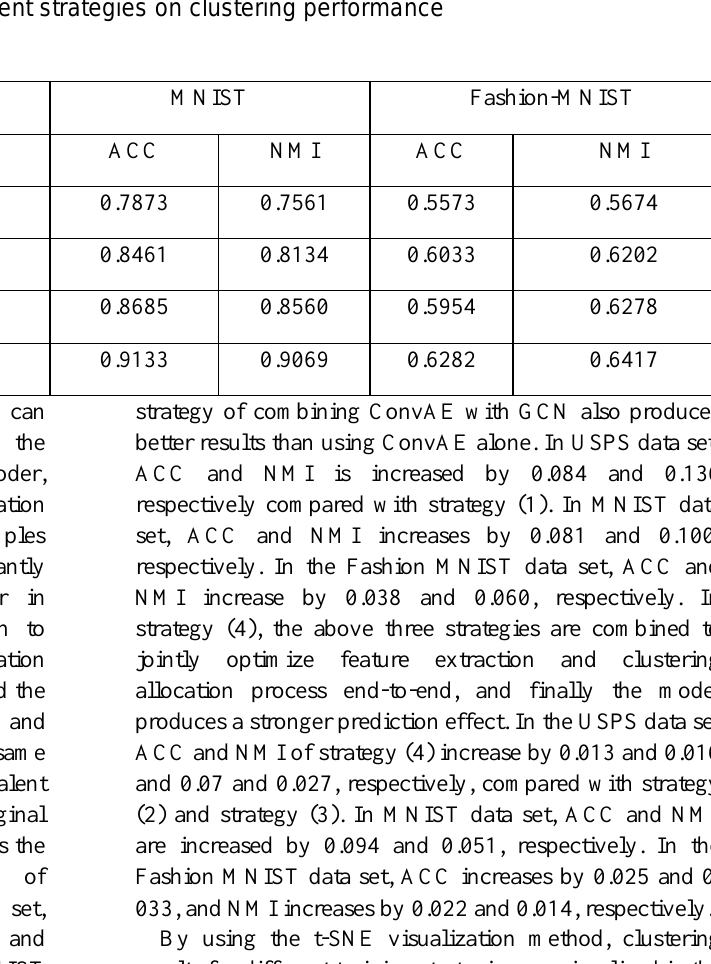
Table 4. Impact of different strategies on clustering